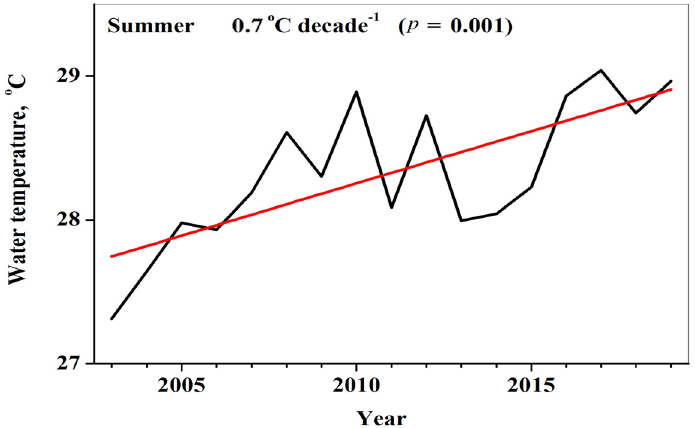
Figure 7. Year-to-year variations of Kinneret near-surface water temperature in summer, based on in-situ measurements, during the 17-year period under study (2003–2019). The straight red lines designate linear fits.